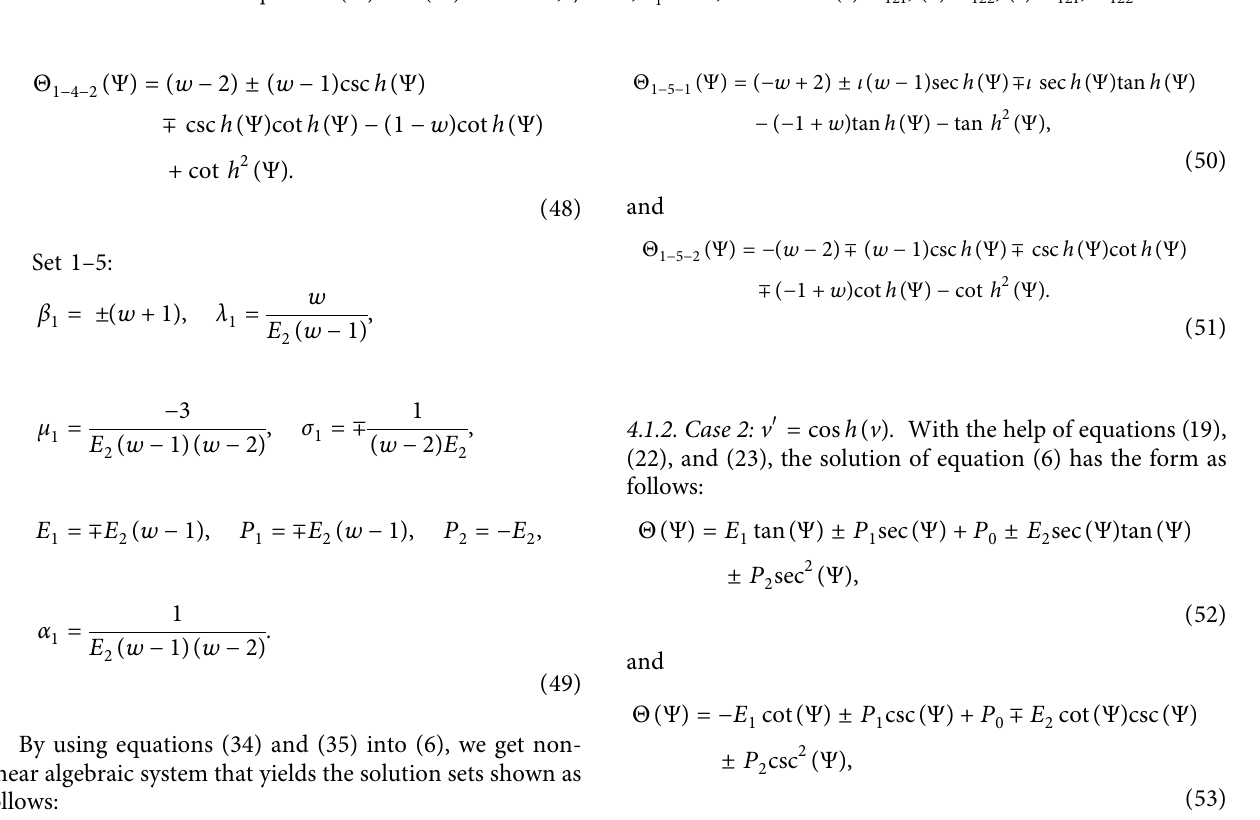
Figure 2: Plots of equations (41) and (42) for m � 2, ξ � 0 . 3, λ